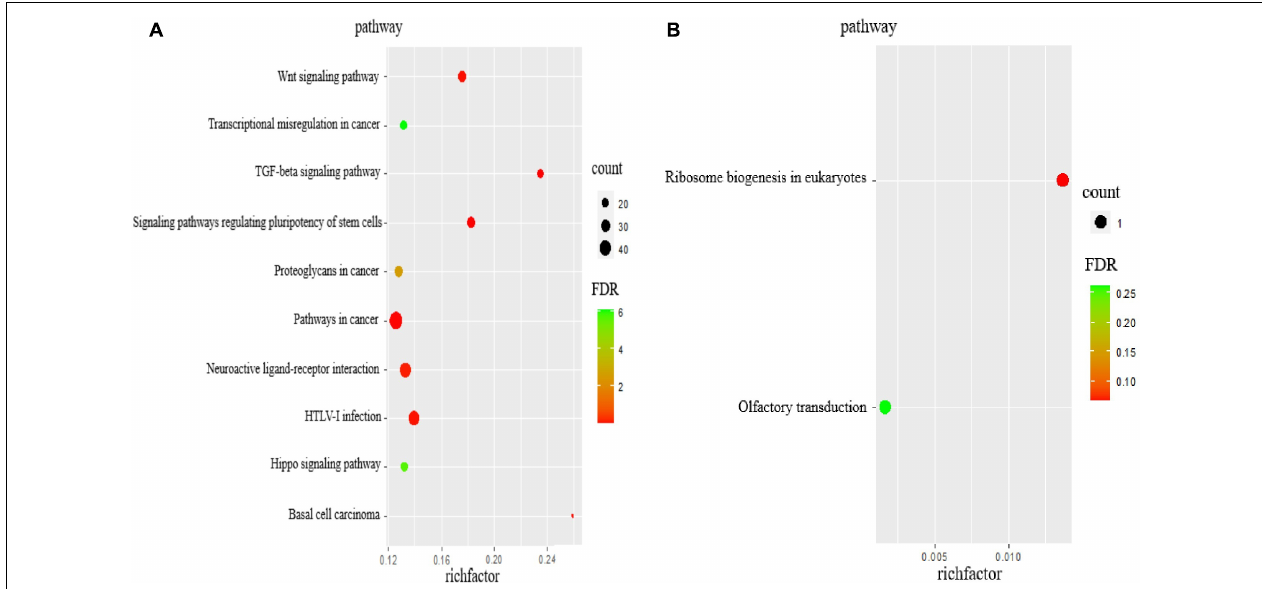
FIGURE 3 | The KEGG analysis of target genes of lncRNAs. (A) KEGG pathway analyses of target genes of all lncRNAs. KEGG enrichment was measured by rich factor, FDR and the number of genes enriched on this pathway. (B) KEGG pathway analyses of target genes of DElncRNAs. KEGG enrichment was measured by rich factor, FDR and the number of genes enriched on this pathway.